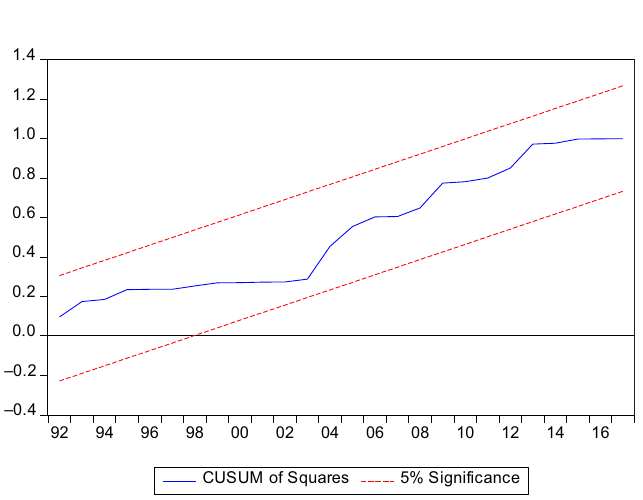
Figure 8. Plot of CUSUM of